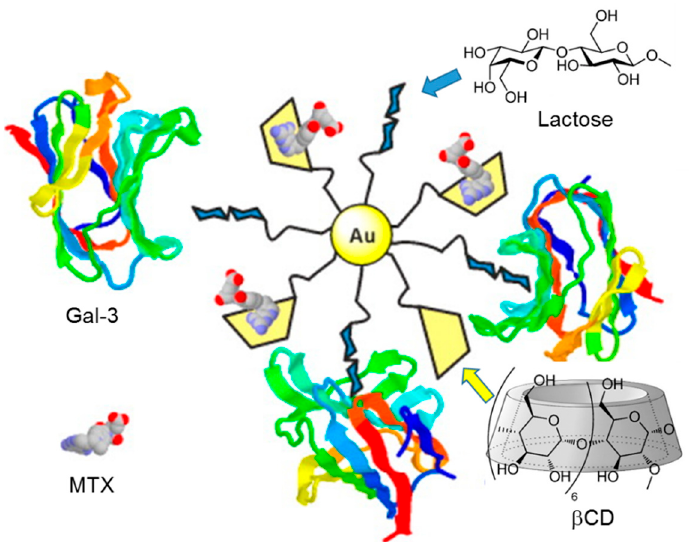
Figure 22. Illustration of the lactose- and β CD-decorated gold nanoparticles developed by Vargas-Berenguel and coworkers [195] for the selective delivery of methotrexate (MTX) to human tumors expressing galectin-3 (Gal-3). Adapted with permission from Reference [195]. Copyright 2014 American Chemical Society.